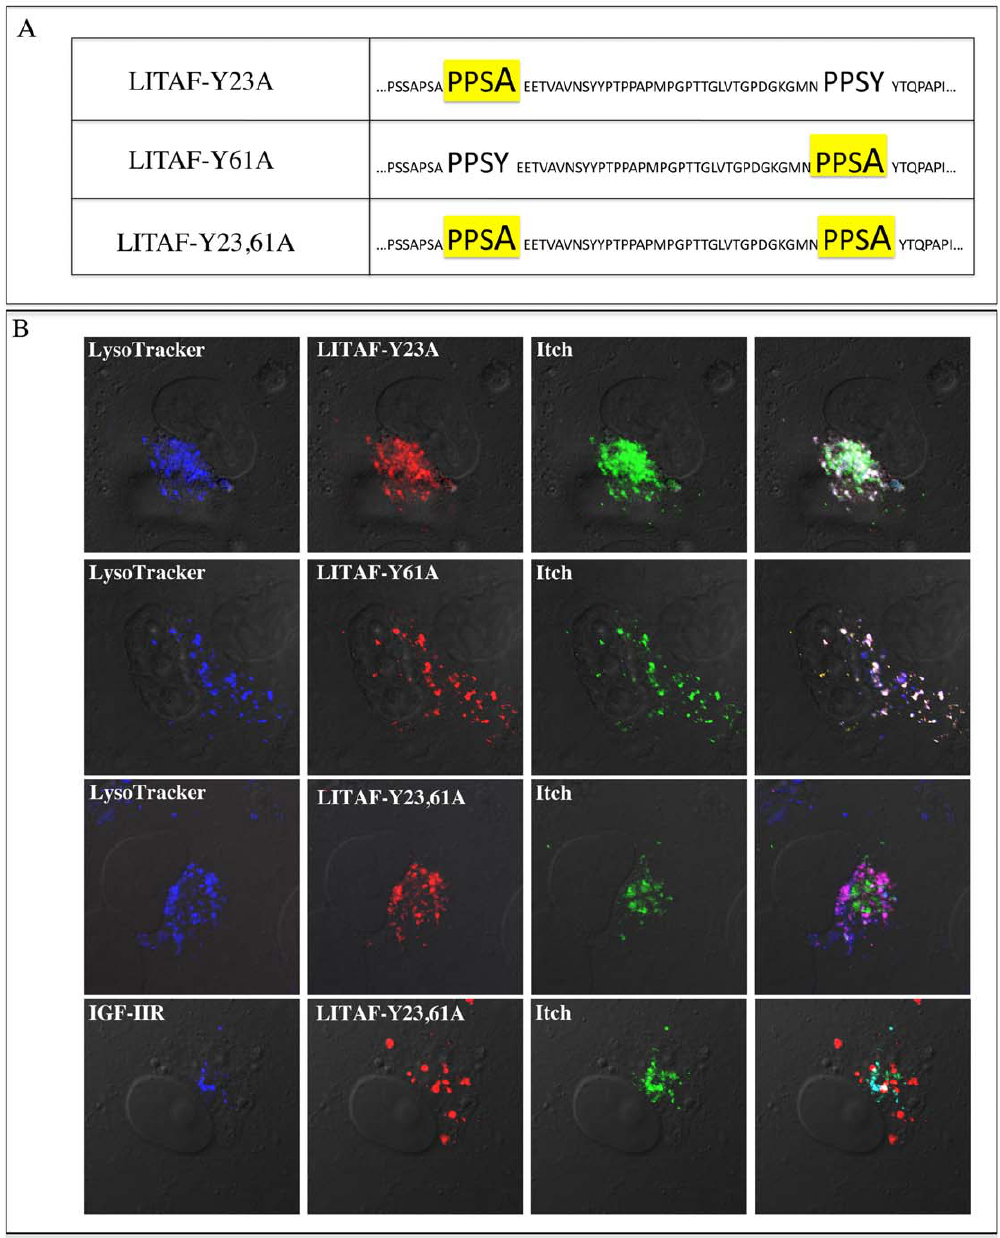
Figure 5. Mutation of both PPXY domains disrupts Itch and LITAF co-localization. (A) Site-directed mutagenesis was used to mutate the two PPXY motifs (either individually or together) located in the N-terminus of GFP-LITAF. (B) Expression constructs containing each mutated GFP- LITAF construct and FLAG-Itch were co-transfected into BGMK cells and 16 hours post-transfection, cells were incubated with LysoTracker (blue), fixed, and processed by indirect immunofluorescence to detect Itch (anti-FLAG; green), LITAF (red), and the trans-Golgi network (anti-IGF-IIR; blue). Cells were visualized using DIC.